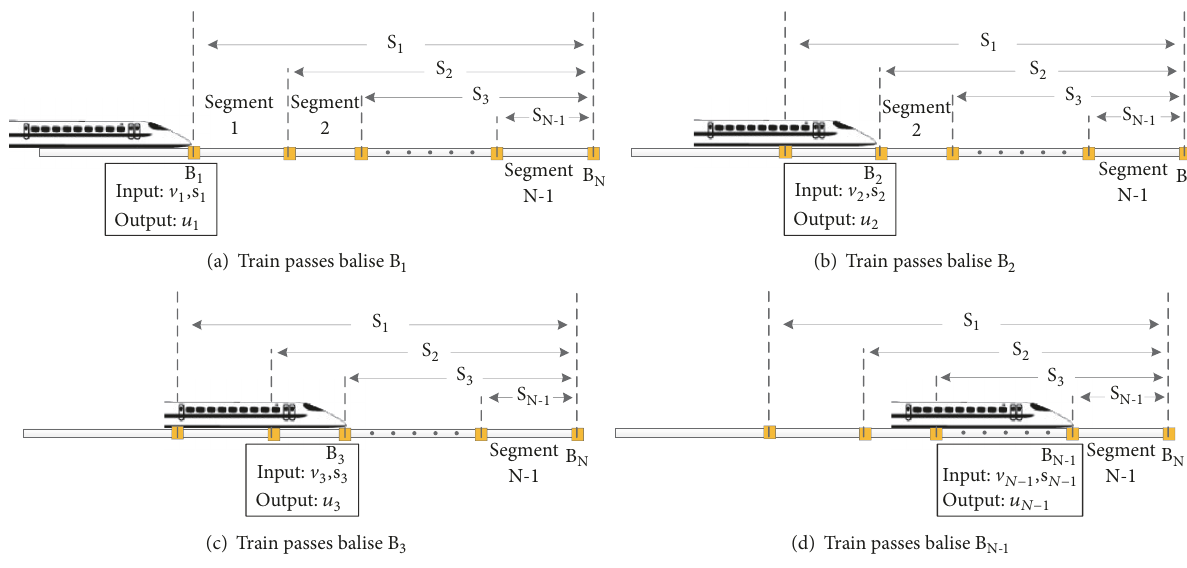
Figure 1: Parking area and balises distribution